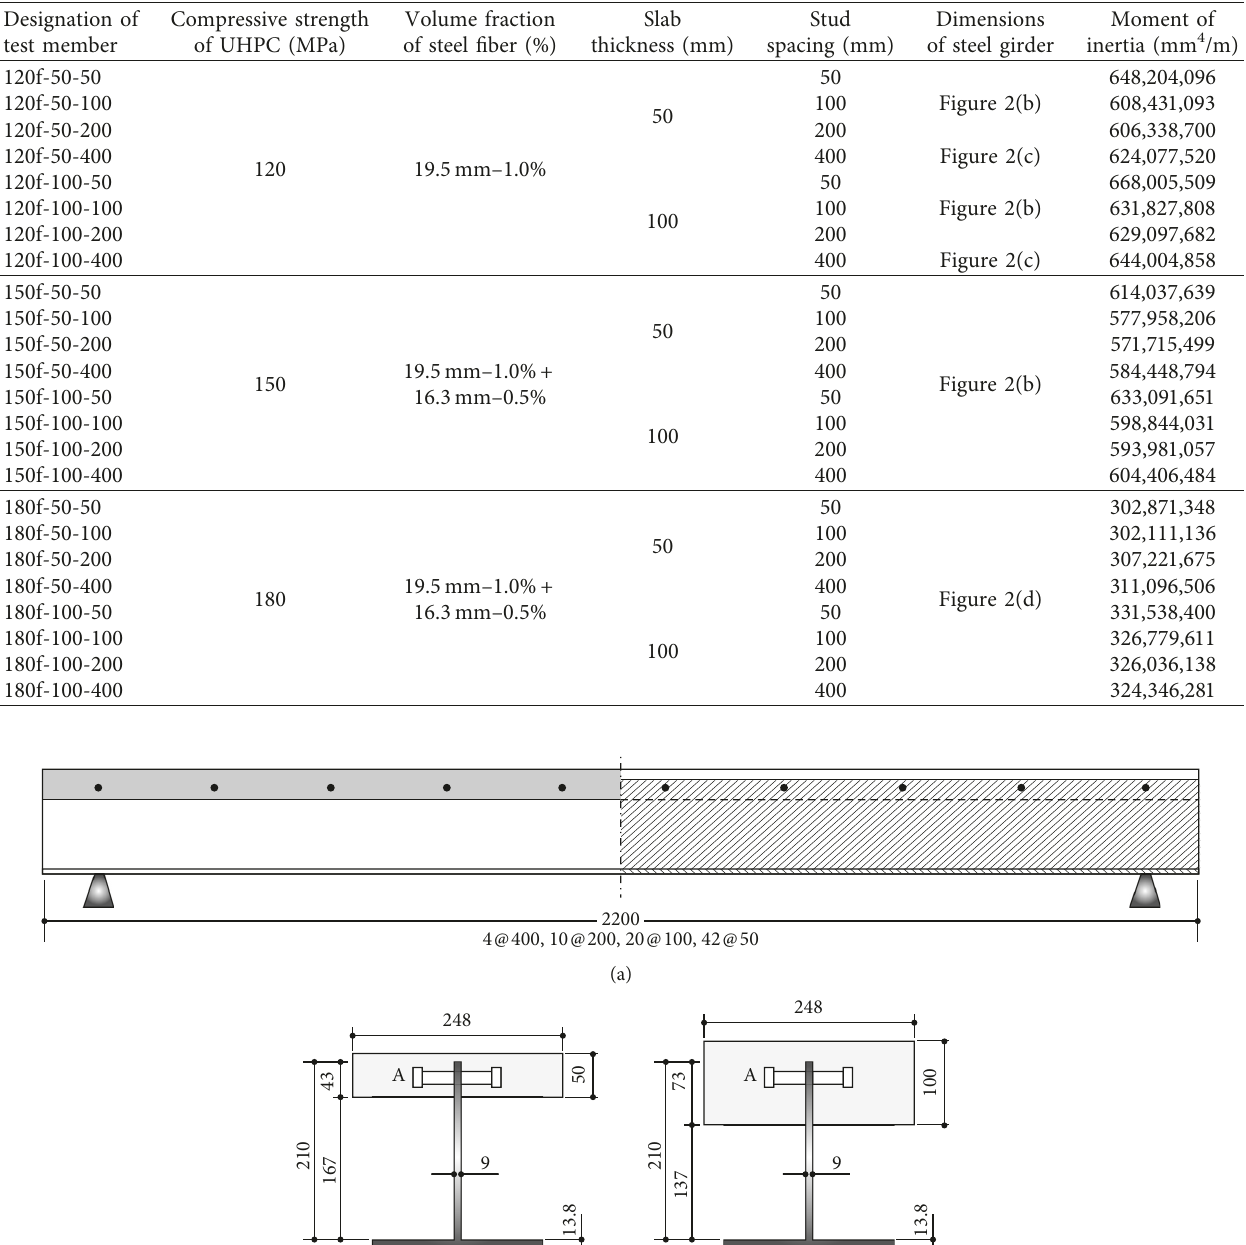
Table 2: Designation and characteristics of composite beam